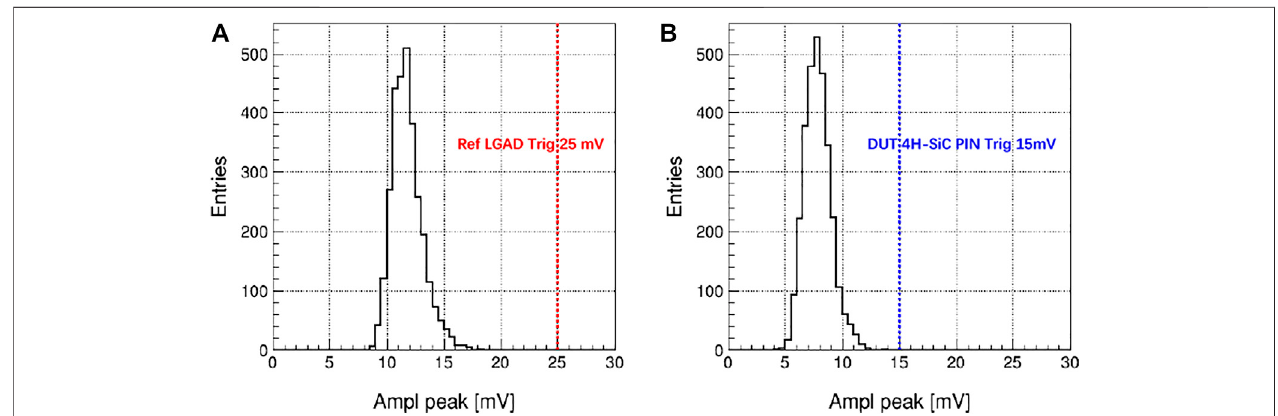
FIGURE 7 | Peak amplitude distribution of noise for (A) 33 μ m Si LGAD with bias voltage U = 200 V and (B) 100 μ m 4H-SiC PIN with U = 500 V . The trigger levels are chosen to eliminate the fake signals from noise spikes.